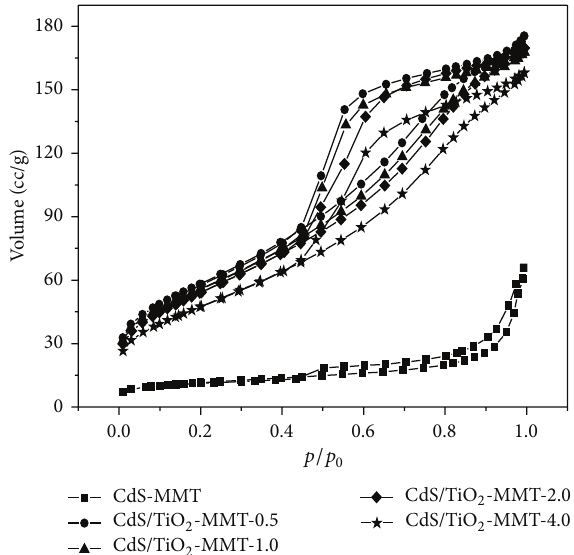
Figure 3: Large angle XRD spectrums of CdS/TiO 2 -MMT. Figure 4: Pore size distribution of CdS/TiO 2